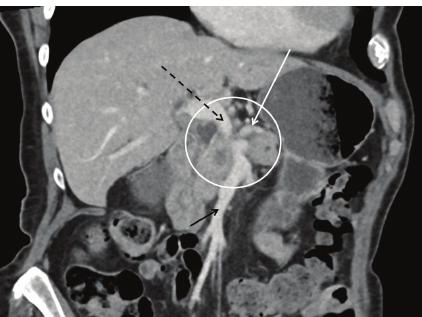
Figure 1: CT scan (coronary reconstruction) showing PDAC tumor infiltration of the portal vein confluence (white circle). Superior mesenteric vein (black arrow), portal vein (broken black arrow), and splenicvein(whitearrow)withoutthrombosis,adequatediameterof the portal, and superior mesenteric vein to perform an end-to- end